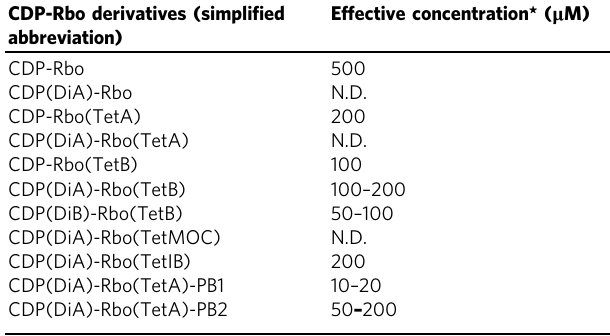
Nomenclature of CDP-Rbo derivatives and their activity are summarized. Details for their structural formula are shown in Supplementary Fig. 4. *Effective concentration: concentration required for glycosylation recovery with levels similar to those in WT cells for CDP-Rbo(TetA) or in ISPD-KO cells treated with 200 μ M CDP-Rbo(TetA) for other derivatives. N.D.; Not